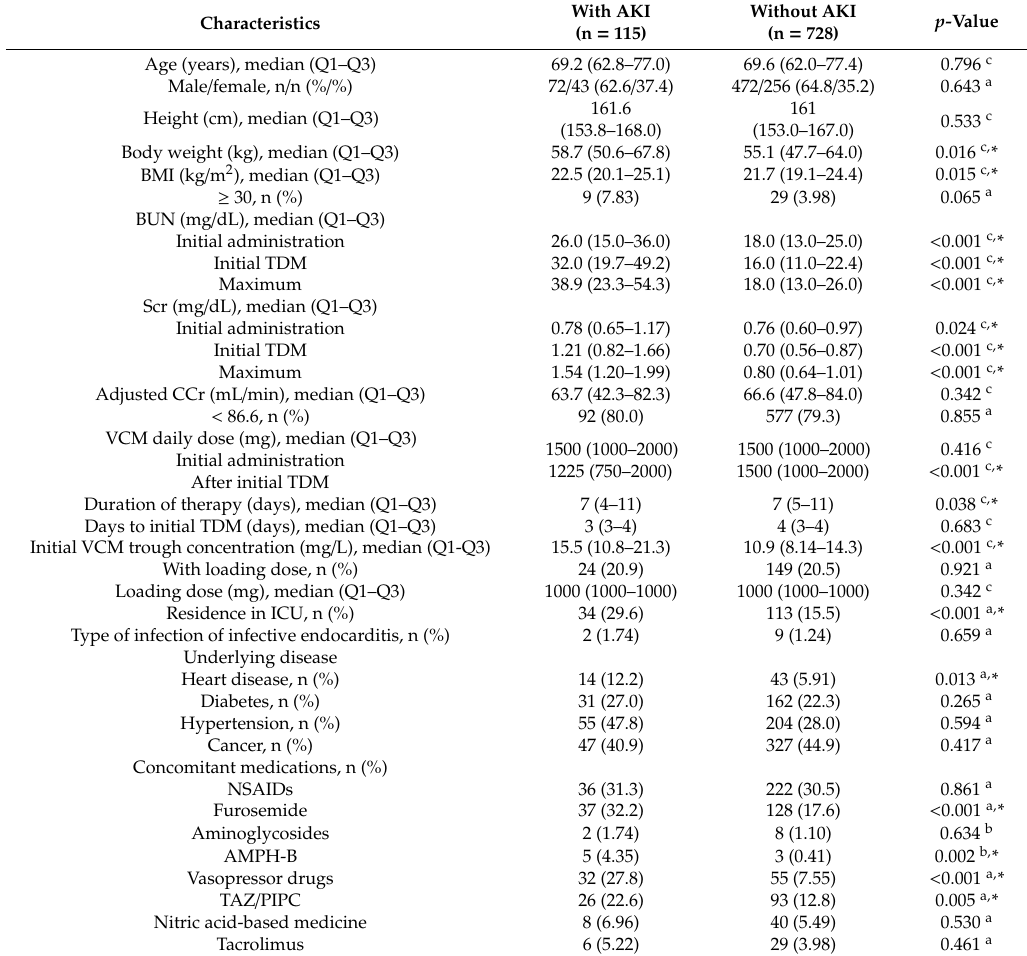
Table 1. Comparison of patient’s characteristics between those with AKI and those without.